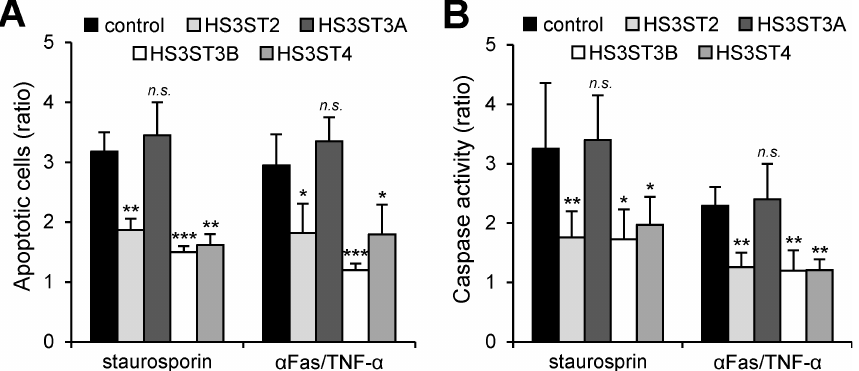
Fig 5. Protective effects of the expression of HS3ST2, HS3ST3B and HS3ST4 against apoptosis. Transfected MDA-MB-231 cells were treated with staurosporin (1 μM) for 5 h or with a mixture of anti-Fas antibody (100 ng/mL) and TNF- α (100 ng/mL) for 16 h. ( A ) The percentage of apoptotic cell population was evaluated by analyzing the binding of fluorescein-conjugated annexin-V. Each bar of histogram represents mean ± S.D. of the rate of apoptotic cells by comparison with untreated control cells. Data were obtained from three distinct experiments. ( B ) In parallel experiments, the activation of caspase-3 was analysed in HS3ST-overexpressing cells and in control cells after exposure to either staurosporin or to the mixture of anti-Fas antibody plus TNF- α .Results are expressed as fold increase in caspase-3 activity by comparison with untreated control cells and correspond to means ± S.D. from three